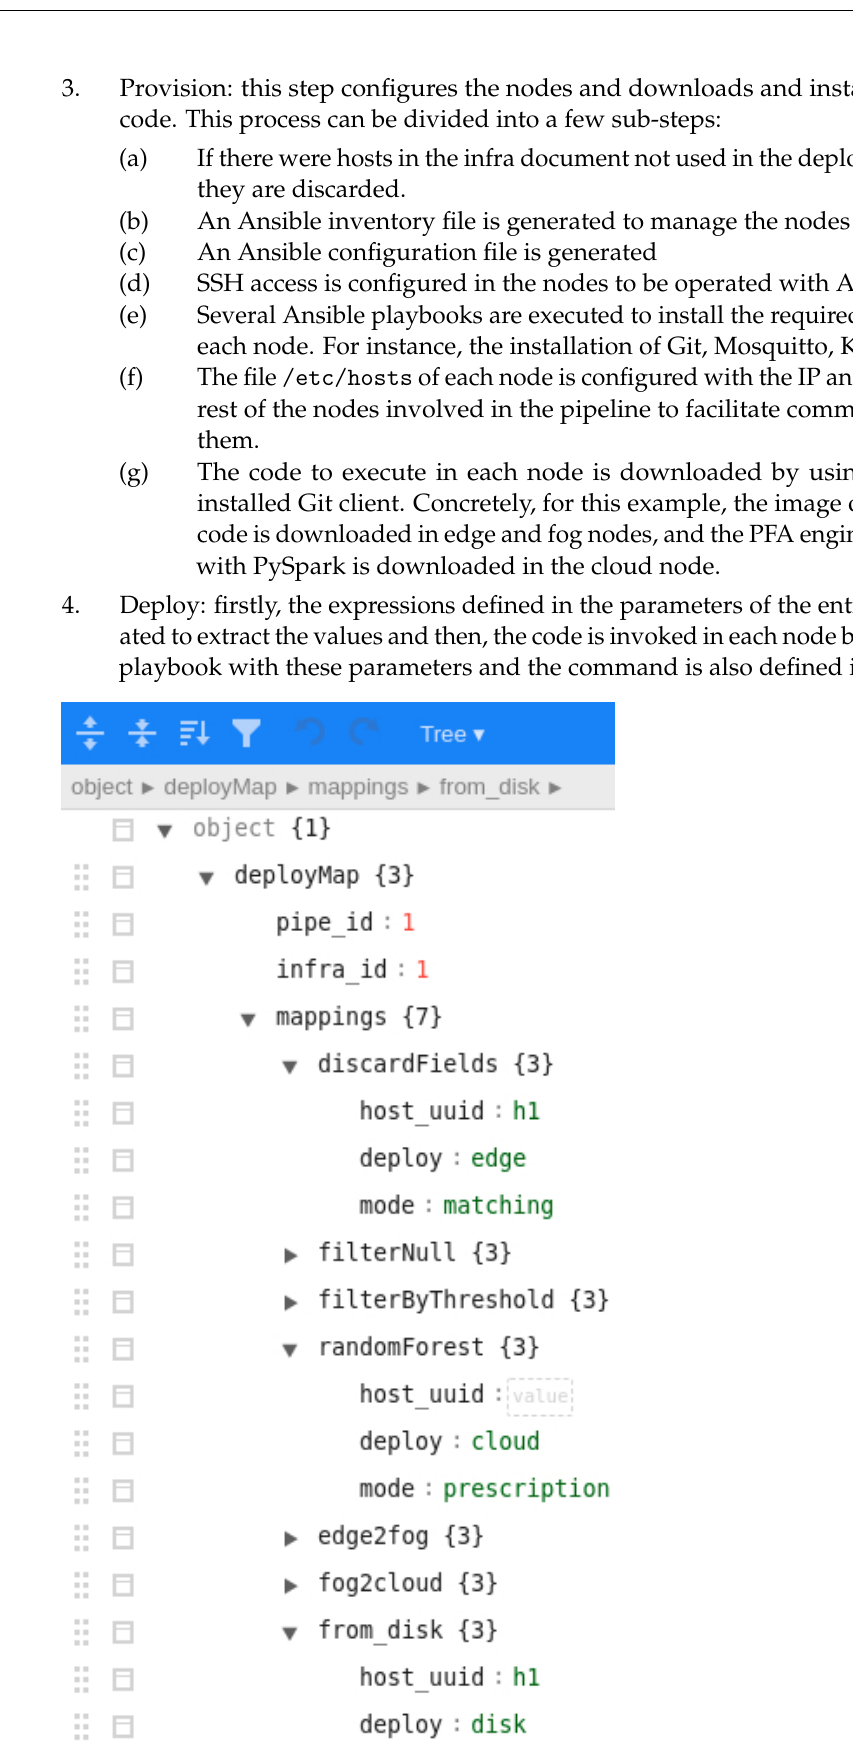
Figure 12. Screenshot of the client when editing the deploy map